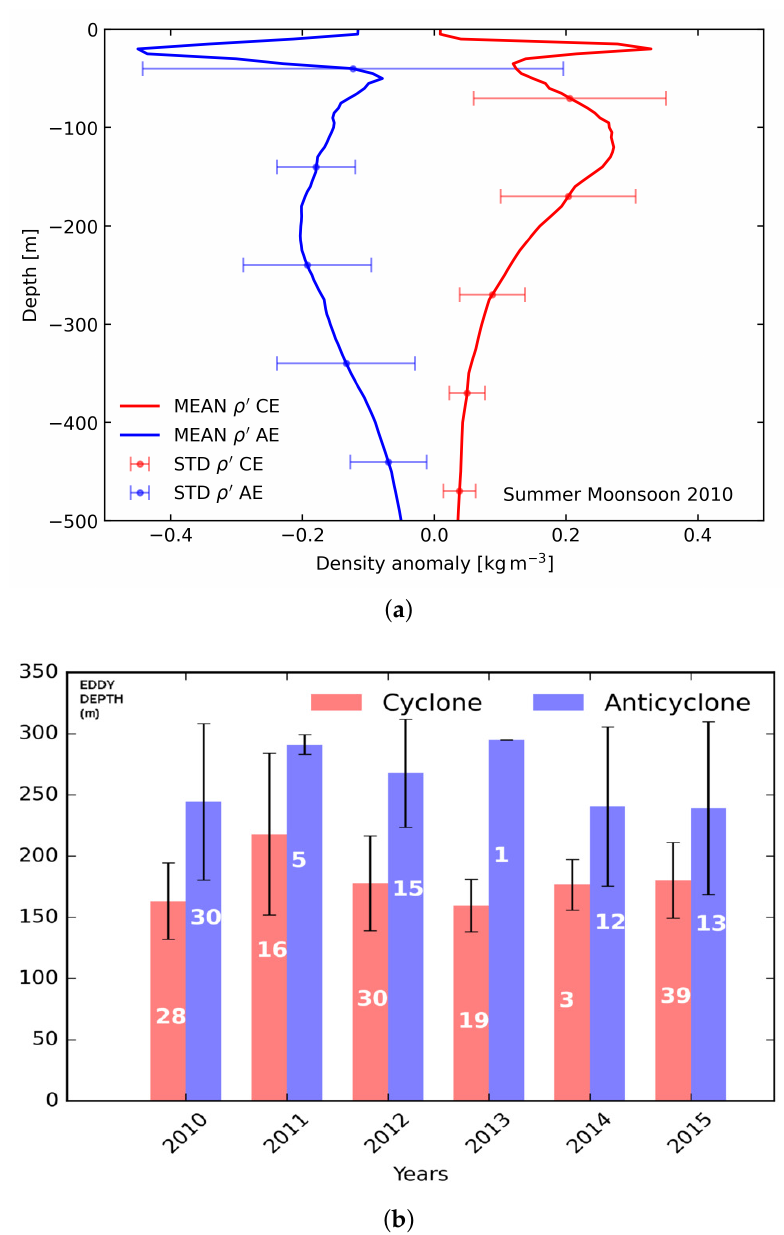
Figure 9. ( a ) Mean density anomaly (error bars for standard deviation (STD)) in the cyclone and anticyclone and ( b ) dipole depth as defined by the depth of the maximal density anomaly (the number of co-localized ARGO float profiles is indicated in white bold